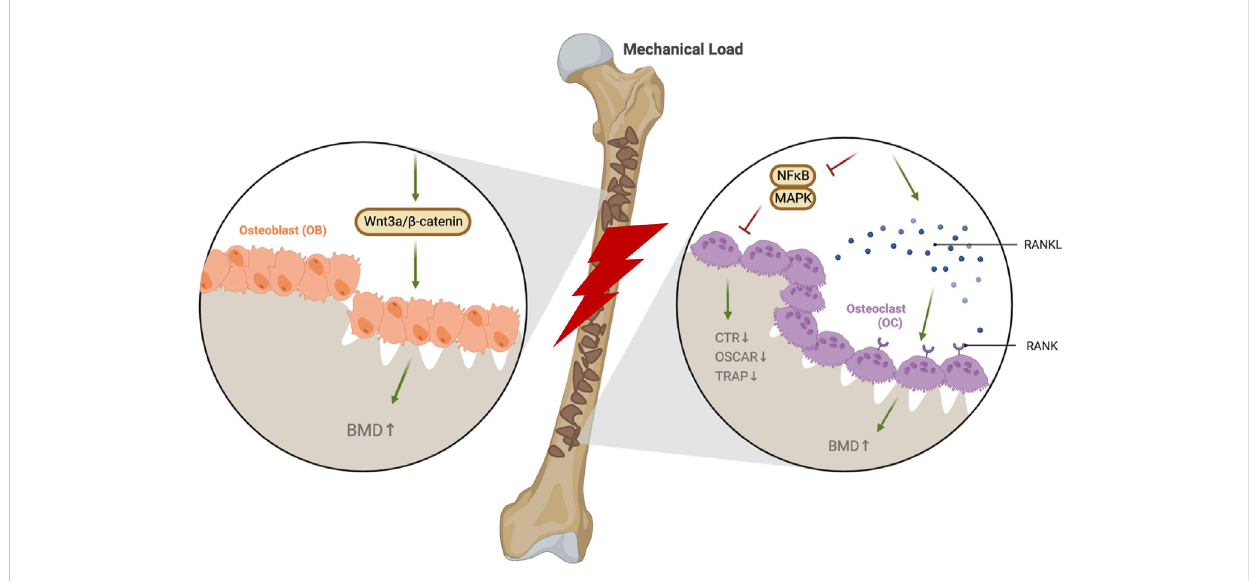
FIGURE 1 Exercise stimulates bone tissue through the mechanical load to enhance bone